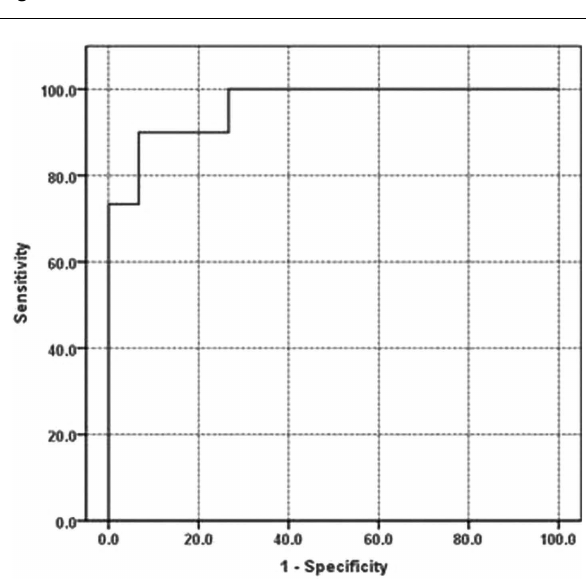
Receiver operating characteristic curve analysis showed the serum